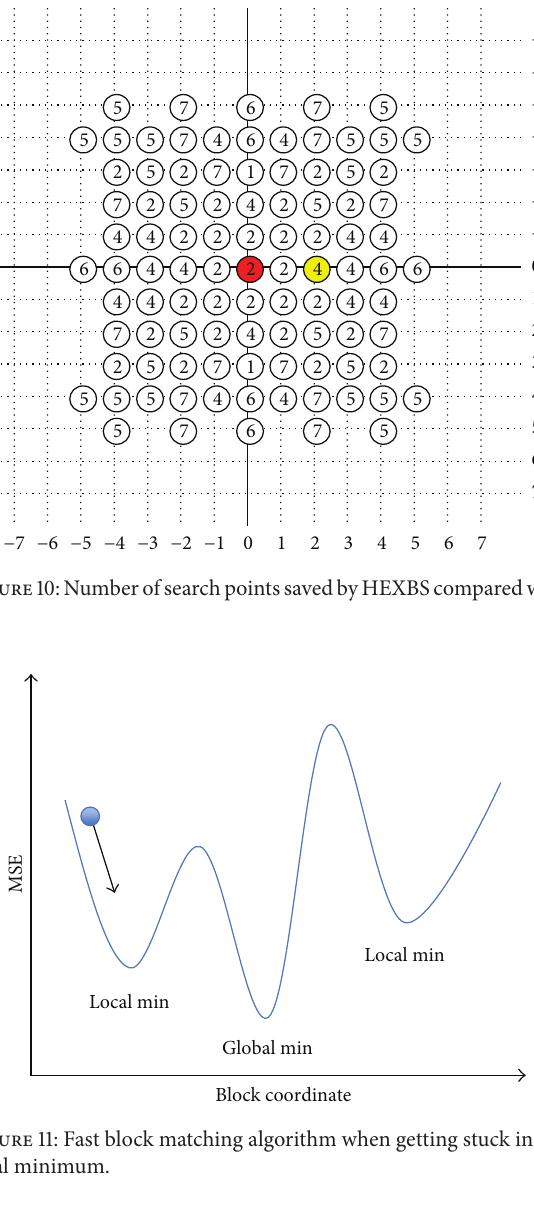
Figure 9: Minimum possible number of search points within the search window with DS.